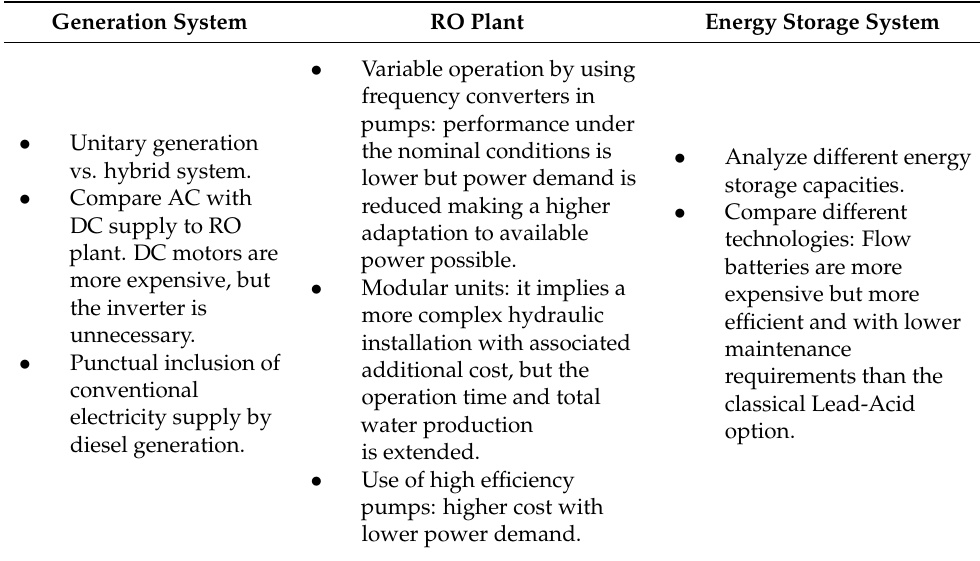
Table 15. List of alternatives to be studied in order to identify the optimal water cost of a PV/wind RO